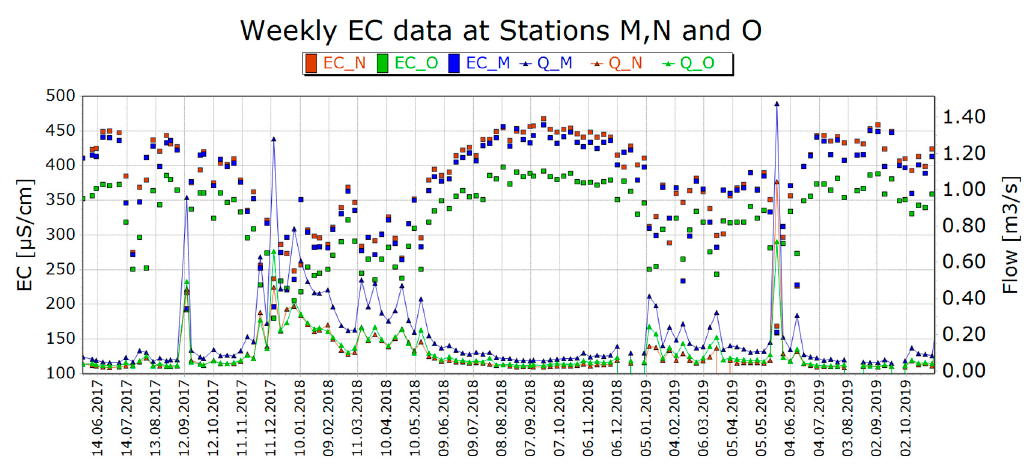
Figure 8. Weekly recorded EC and flow at stations M, N and O.